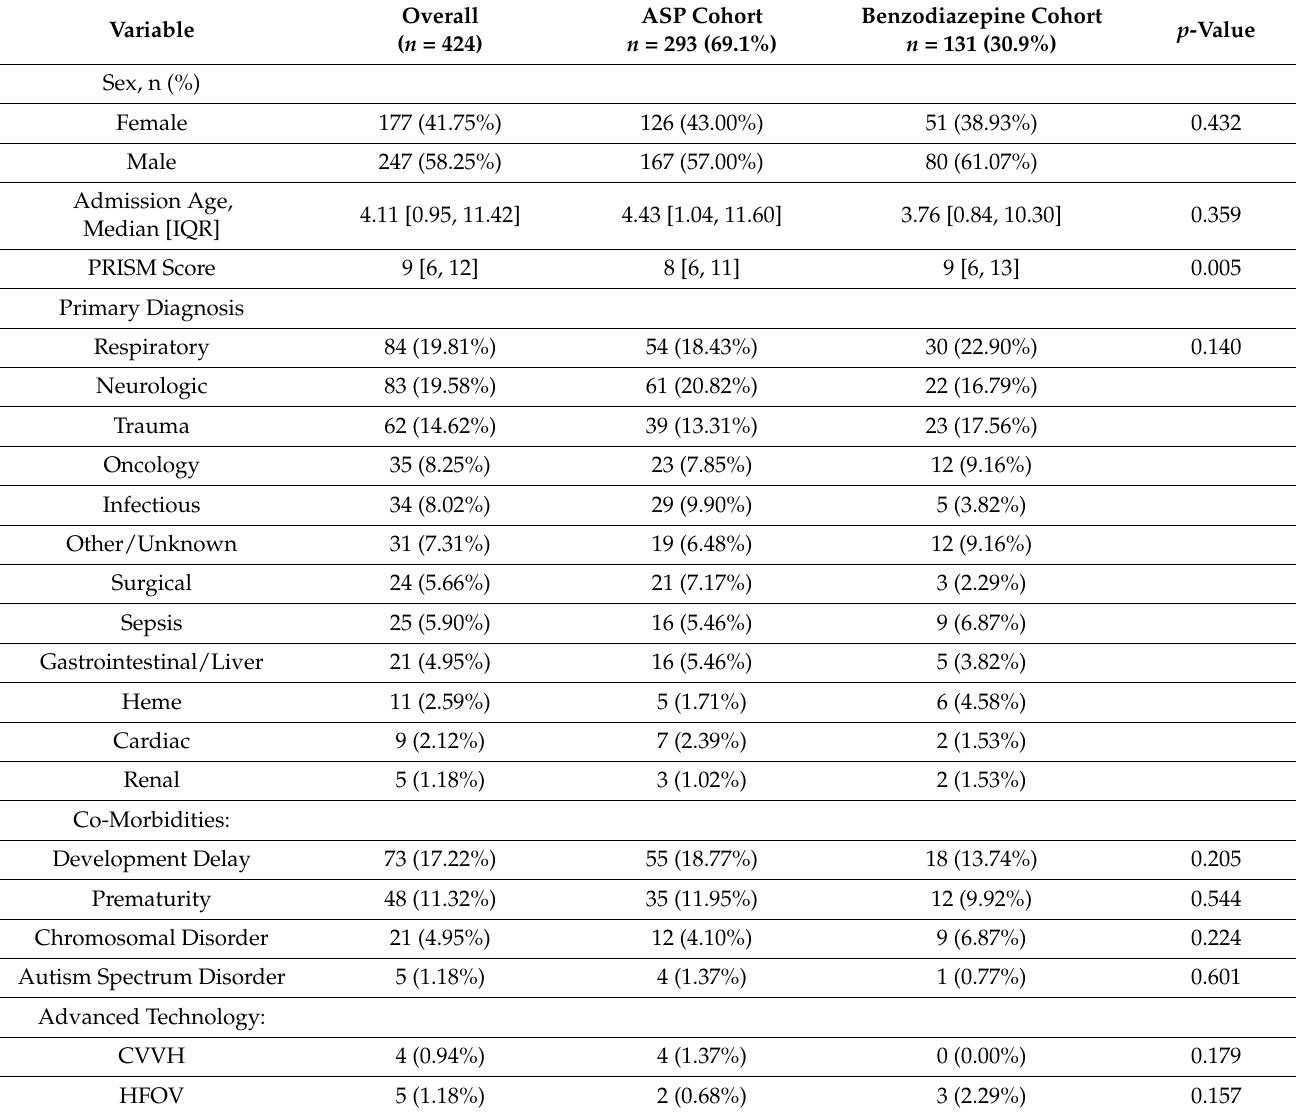
Table 1. Demographic and clinical characteristics of study cohort ( n =